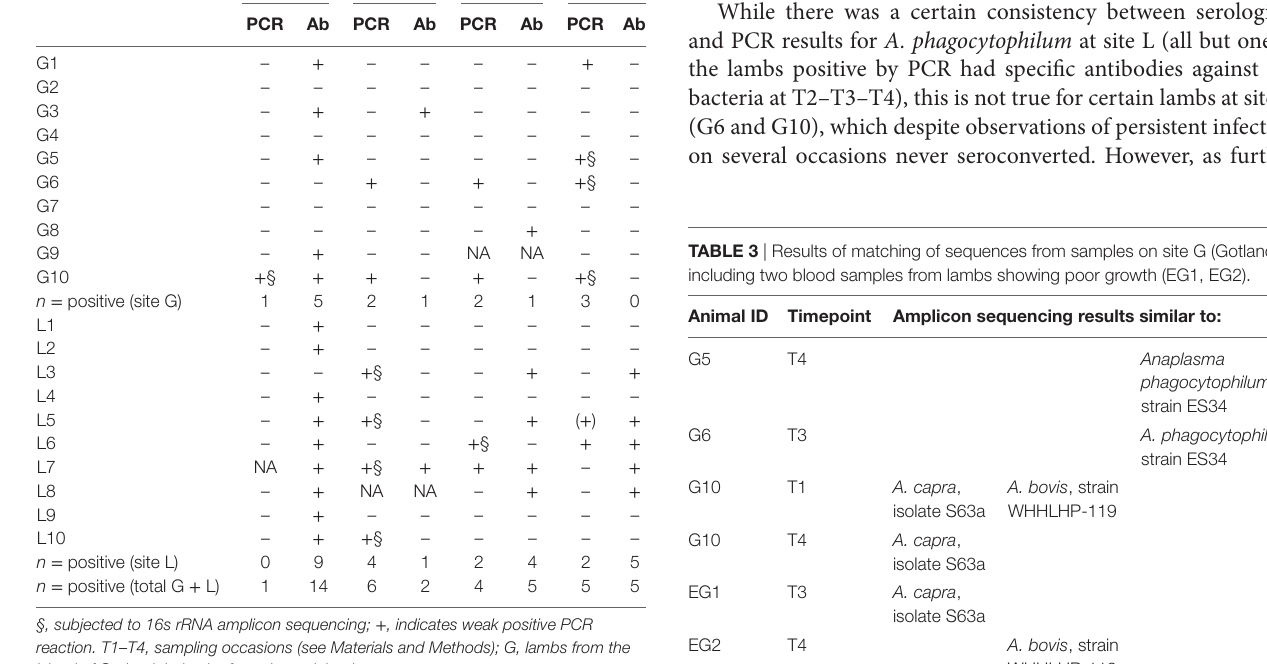
TaBle 2 | Results of serology (Ab) and polymerase chain reaction (PCR) analyses for Anaplasma phagocytophilum . animal iD T1 T2 T3 T4